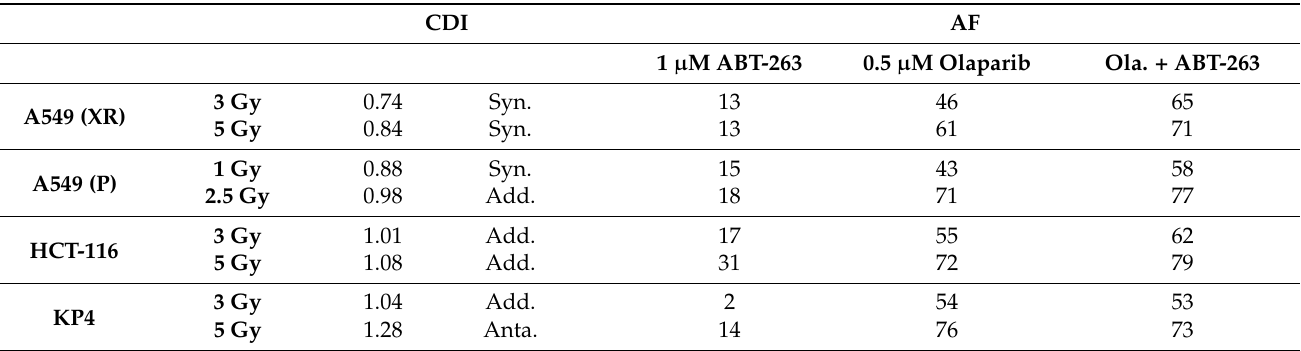
Table 1. Coefficient of drug interaction and amplification factor calculated with the survival fraction of A549, HCT-116 and KP4 cells after irradiation with 3 and 5 Gy X-rays (XR) or 1 and 2.5 Gy protons (P). The survival fractions were evaluated in comparison to un-irradiated